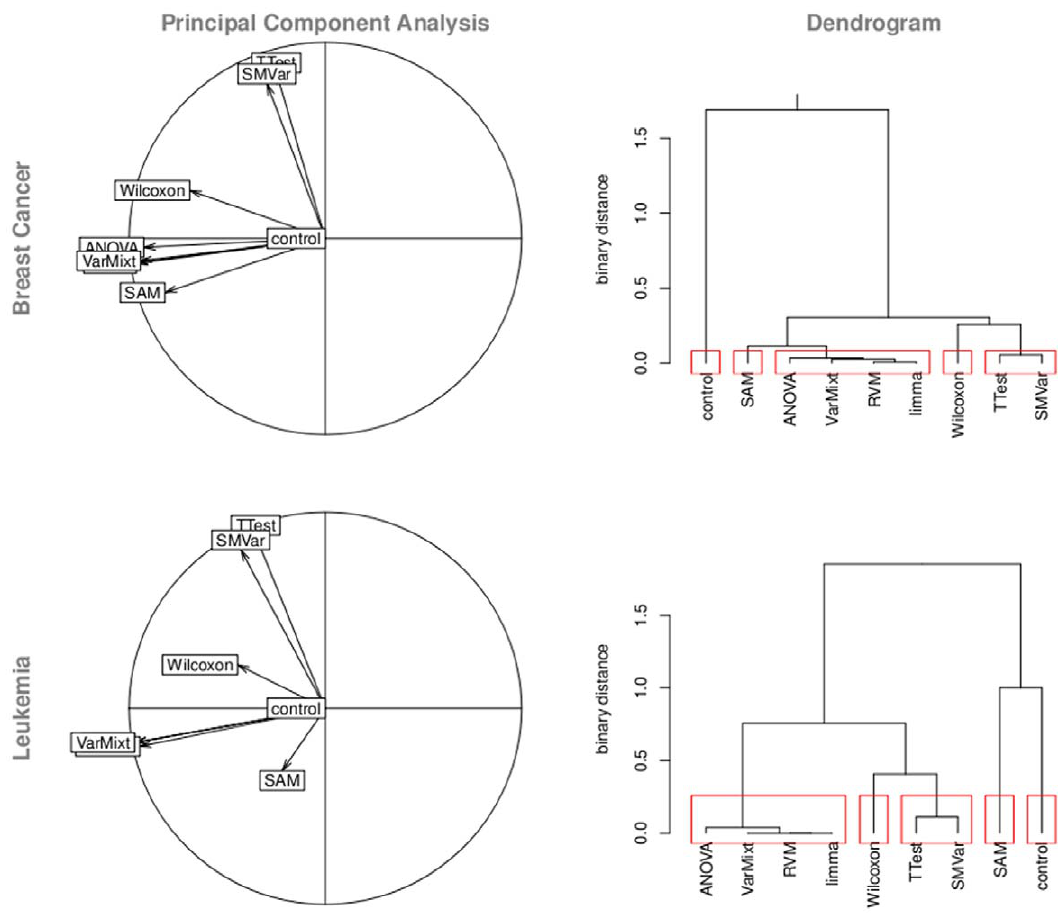
Figure 2. Gene list analysis. PCAs and dendrograms are generated based on the gene lists resulting from the application of the eight tests of interest and the control-test. Here we show results for two data sets comparing ESR1 expression in breast cancer and gender in leukemia. Both outline five clusters of tests.